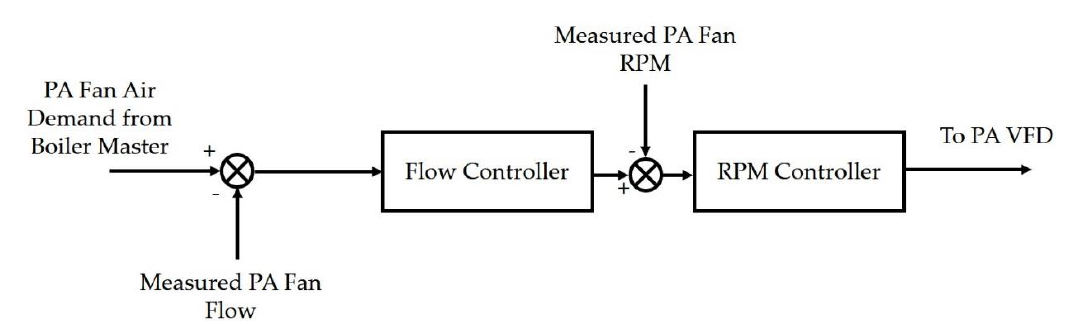
Figure 6. Primary Air (PA) Fan Air Control Scheme.